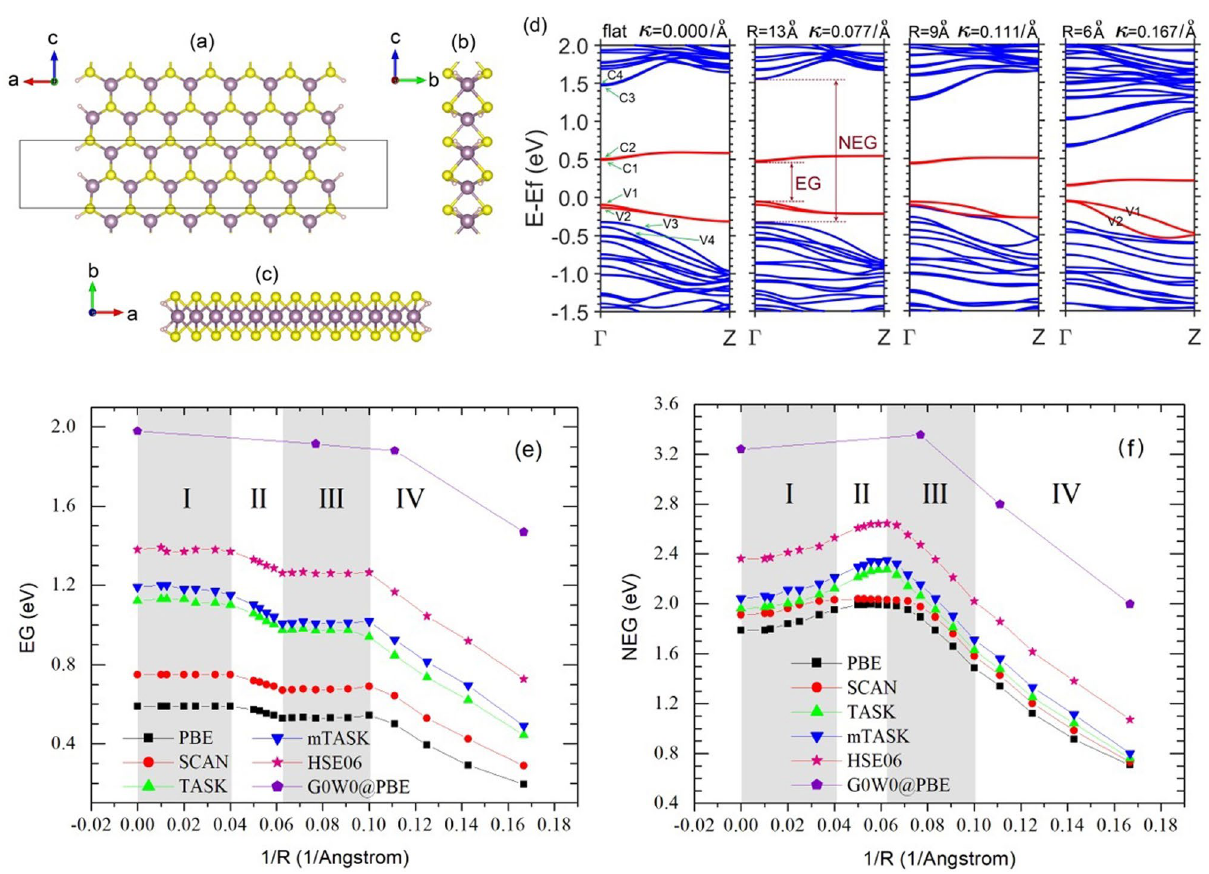
Figure 1. The structure of hexagonal armchair monolayer MoS 2 nanoribbon A n MoS 2 with n = 13 and its band structure and gap evolutions with the bending curvature radius. ( a ) structure view along axis y. The supercell vectors a, b and c are aligned with axes x, y and z, respectively. The box outlines the periodical unit of the nanoribbon along axis z. The two hydrogen-passivated armchair edges are on the left and right sides. The view along axis x is in ( b ) and along axis z is in ( c ). The blue balls represent Mo atoms, the yellow ones for S atoms, and small white ones for H atoms. The PBE band structure evolution with the bending curvature radius is in ( d ). The conduction bands C1, C2, C3… are numbered upwards, while the valence bands V1, V2, V3… are numbered downwards. The four bands near the Fermi level are plot in red, while others are in blue. The edge band gaps (EG) in ( e ) and non-edge band gaps (NEG) in ( f ) as a function of bending curvature κ for the A13MoS 2 nanoribbon are shown. The shaded areas highlight the different curvature regions. The results from PBE, SCAN, TASK, mTASK, HSE06 and G 0 W 0 are shown, and have nearly the same trend. EG is defined as the energy difference between C1 and V1 at the Ŵ point, and NEG as that between C3 and V3. When V1 and V2 are merged into the valence band continuum, NEG is the difference between C3 and